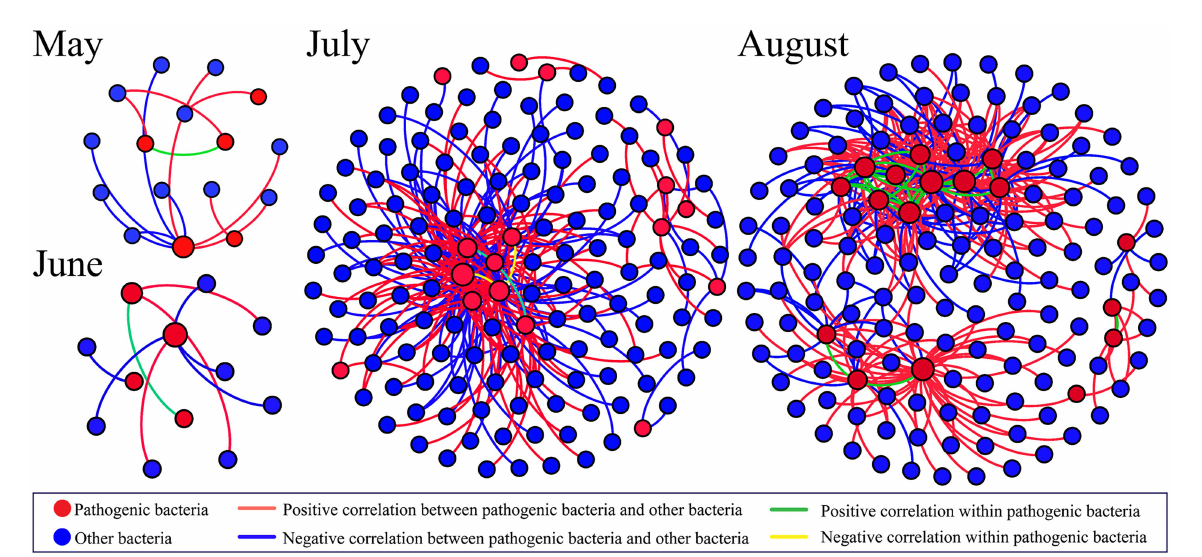
FIGURE 7 Network analyses showing the co-occurrence pattern within pathogenic bacteria and between pathogenic bacteria and other bacteria OTUs in the Bohai Sea from May to August. This figure shows significant correlations.